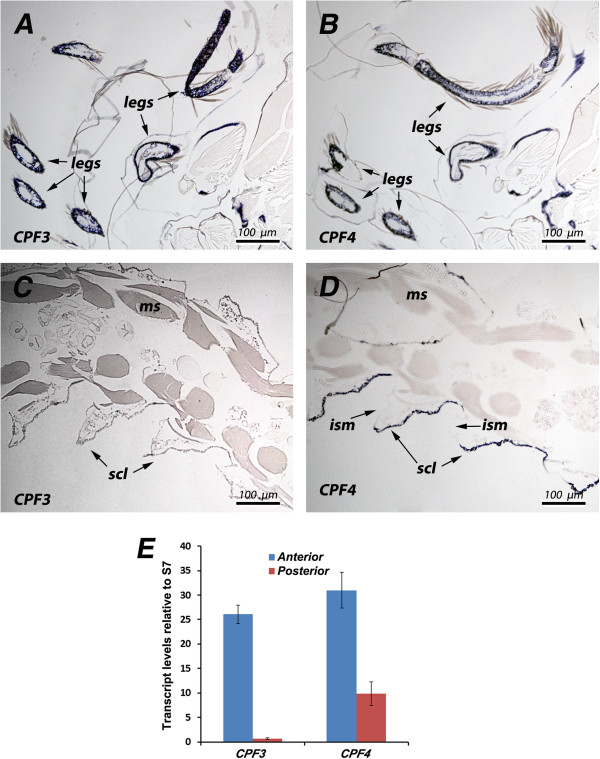
Comparison of CPF3 and CPF4 expression in male pharate adults (P24). Probes for both genes hybridize equally to the limbs (A, B). However, only CPF4 hybridizes to abdominal sclerites (D), a location not seen with CPF3(C). (E) RT-qPCR of CPF3 and CPF4 in pharate adult anterior (head and thorax) and posterior (abdomen) at P24. Standard errors are shown. ism, intersegmental membrane; scl, sclerites; ms, muscle.